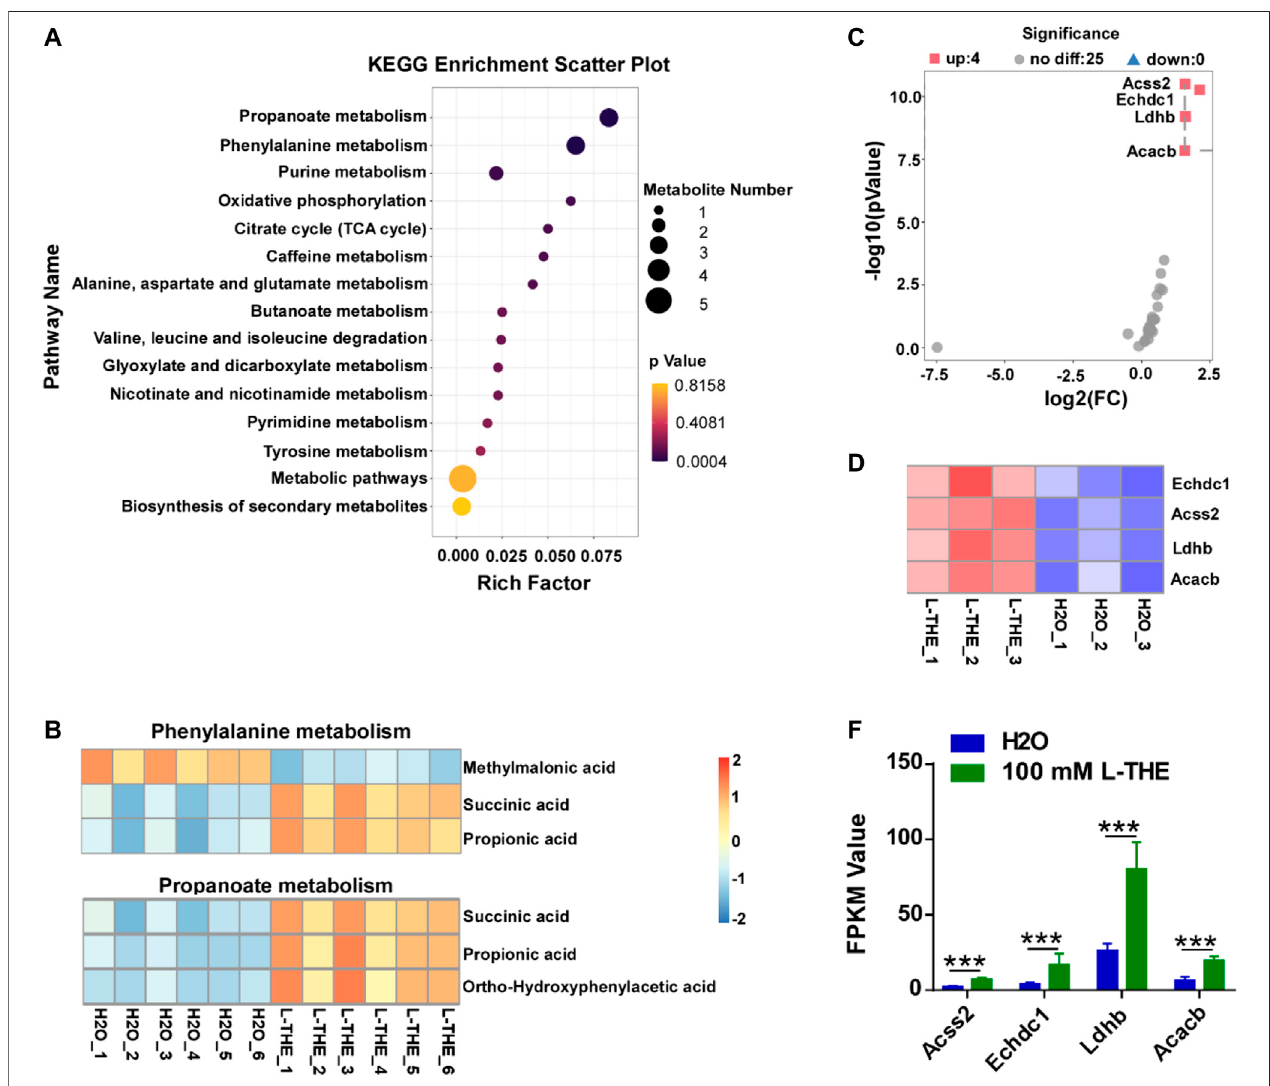
FIGURE 6 | L-THE upregulates the propanoate metabolism by increasing the expression of propanoate metabolism associated genes. (A) Scatter plot for KEGG analysis based on untargeted metabolism data from IMQ-induced psoriasis mice treated with 100 mM L-THE or H2O for 5 days. (B) Heatmap showed the signi fi cantly changedproductionofphenylalanineandpropanoatemetabolismbasedonuntargeted metabolismdatafromIMQ-inducedpsoriasismicetreatedwith100 mM L-THE or H2O for 5 days. (C,D) Volcano plot. (C) showed the expression of propanoate metabolism associated genes, and heatmap. (D) showed the signi fi cantly differentiated propanoate metabolism genes based on RNA-seq data from IMQ-induced psoriasis mice treated with 100 mM L-THE or H 2 O for 5 days. (E) The FPKM Value of Acss2, Echdc1, Ldhb, and Acacb in (D) .